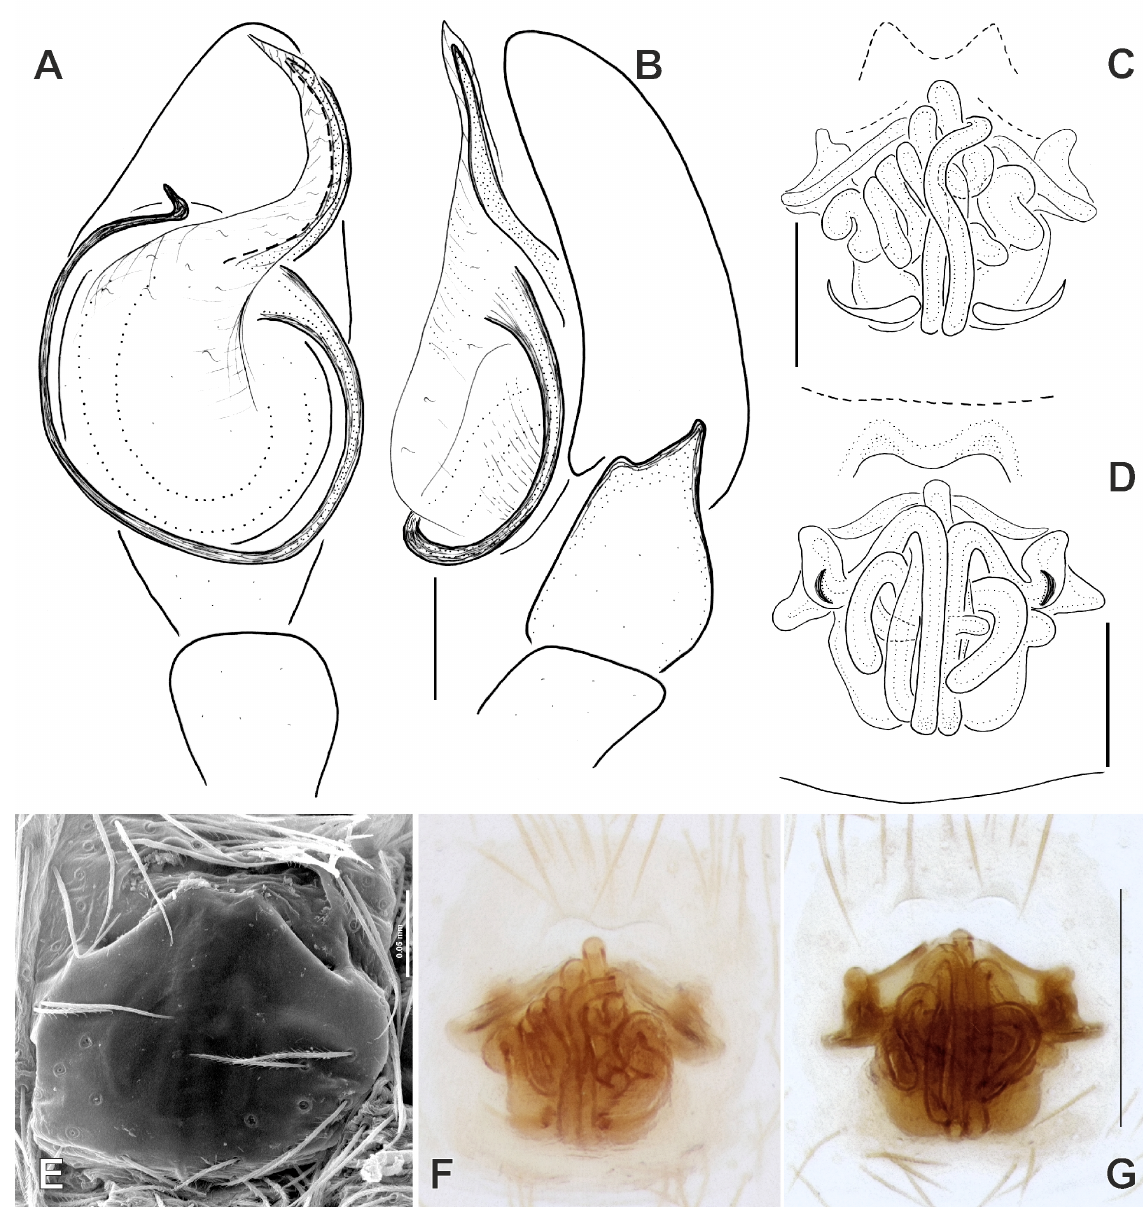
Fig. 23. Synaphosus martinezi sp. nov. (A–B = holotype, ♂, MHNG; C–G = paratype, ♀, MHNG), copulatory organs. A–B . Palp, ventral and retrolateral views. C, E–F . Epigyne, ventral view. D, G . Epigyne, dorsal view. Scale bars: A–D = 0.1 mm; E = 0.05 mm; G = 0.2